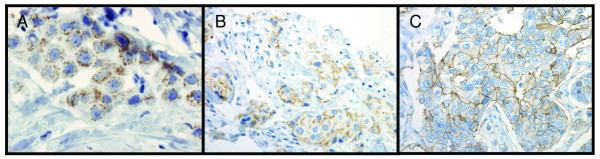
Sub-cellular location for samples staining positive for ADIPOR1, ADORA1 and CD46. Brown colour represents staining of the specific protein. Immunohistochemistry staining performed for these proteins on tissue microarrays show staining of ADIPOR1 (A) and ADORA1 (B) as granular staining in the cytoplasm, and expression of CD46 concentrated to the cell membrane (C).